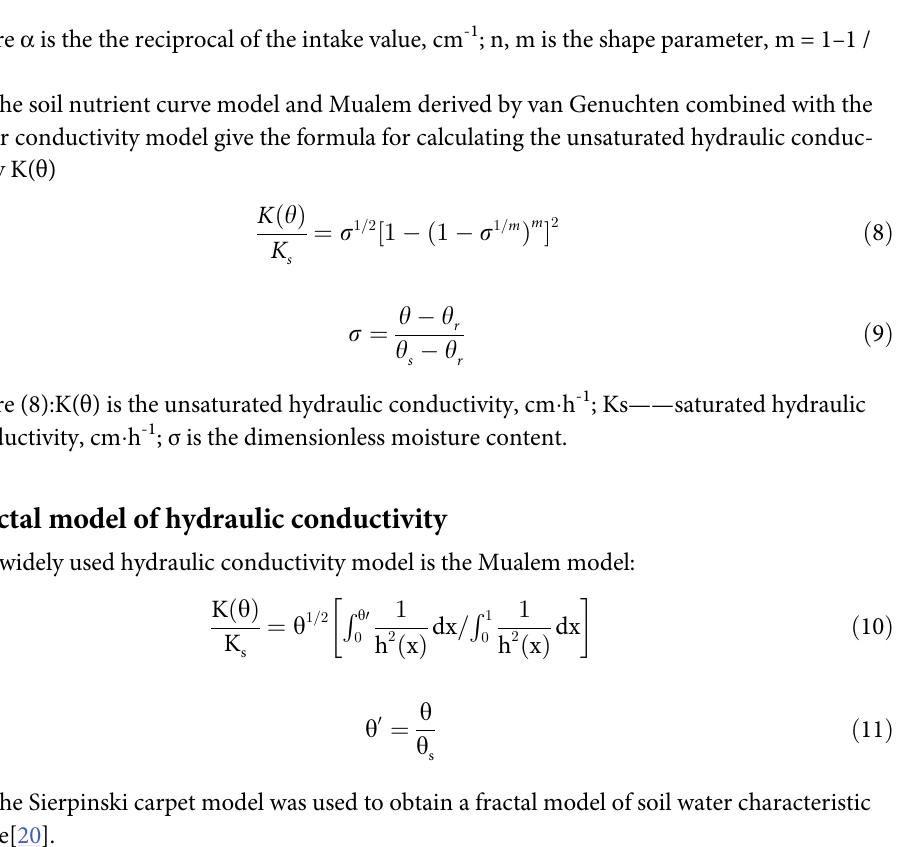
Fig 1. The SEM images of soft rock and sand compound soil with different mixing ratio. Fig 1A, 1D, 1G and 1J are the SEM images of soft rock and sand compound soil 0:1, 1:5, 1:2, 1:1,respectively; Fig 1B, 1E, 1H and 1K are the pore distribution of soft rock and sand compound soil 0:1, 1:5, 1:2, 1:1,respectively; Fig 1C, 1F, 1I and 1L are the macropore distribution of soft rock and sand compound soil 0:1, 1:5, 1:2, 1:1,